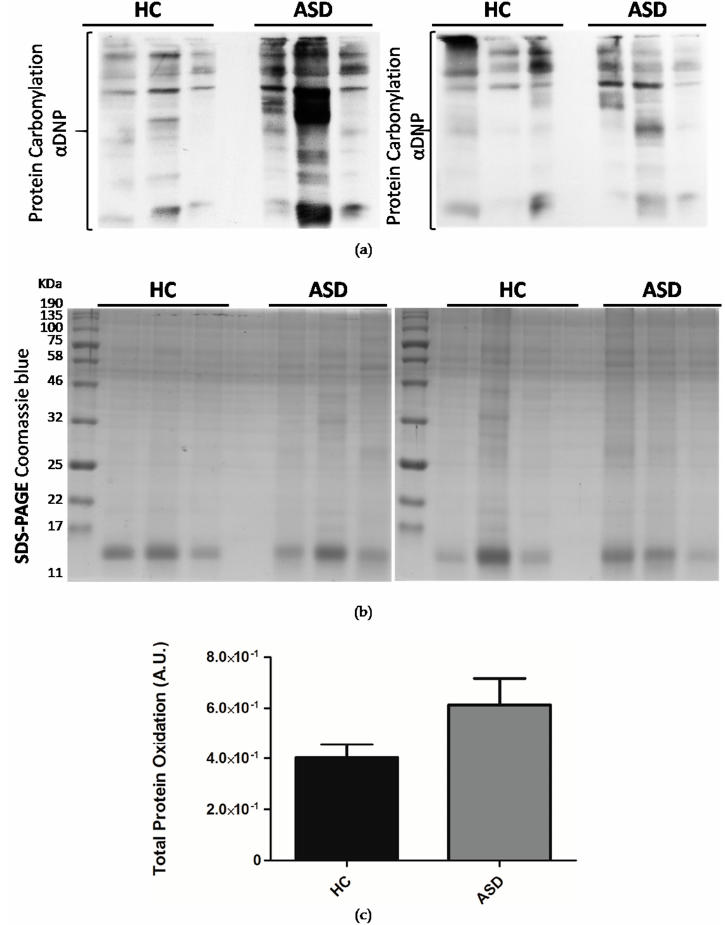
Figure 2. Oral mucosa total protein oxidation levels in Chilean children with ASD. ( a ) Total proteins were isolated from oral mucosa cells by TRIzol™ reagent (Invitrogen) and fractionated by SDS-PAGE (sodium dodecyl sulfate-polyacrylamide gel electrophoresis). Protein carbonylation was detected with the Oxyblot Protein Detection Kit. α DNP: Anti-2,4-dinitrophenylhydrazone antibody. ( b ) SDS-PAGE Coomassie blue staining of SDS-PAGE of derivatized proteins. ( c ) Densitometry quantification of protein carbonylation was made with the ImageJ software. Carbonylation of proteins was normalized by Coomassie blue staining. Each bar represents the mean ± SEM, analyzed by unpaired t-test. Healthy controls (HC), n = 11 and ASD children, n =